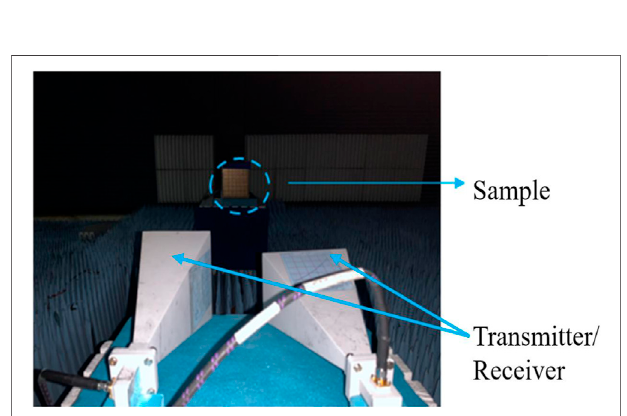
FIGURE 10 | Experimental con fi gurations in the microwave anechoic